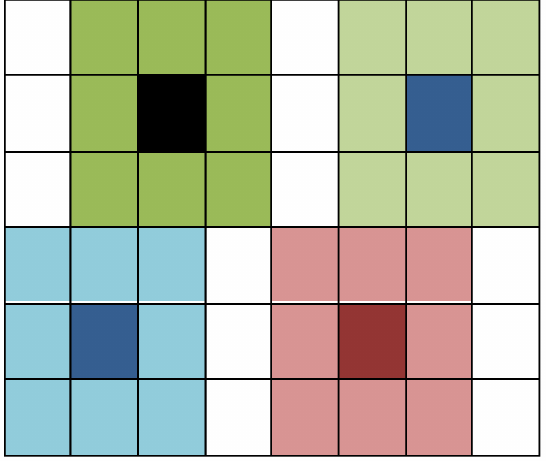
Figure 1. Octrees of a pixel matrix with size 6 ×